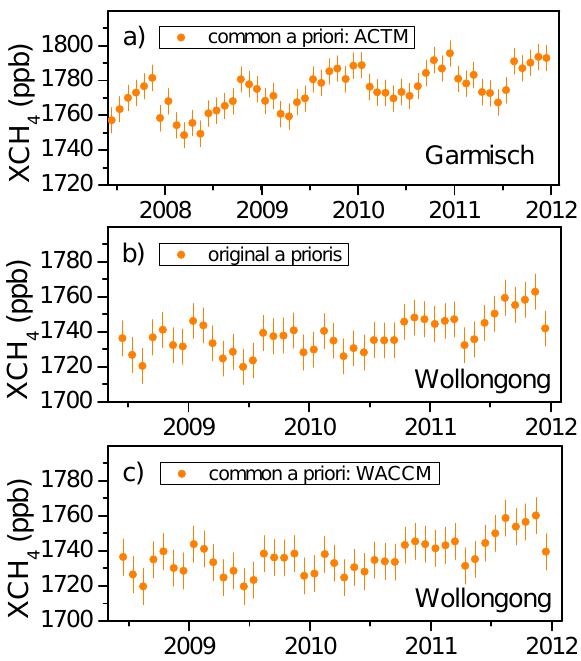
Fig. 8. Joint NIR and MIR time series, (a) for Garmisch (ACTM based), (b) for Wollongong based on original a prioris, and (c) for Wollongong using WACCM as common prior. Error bars are 2- σ uncertainites as explained in Fig. 4.